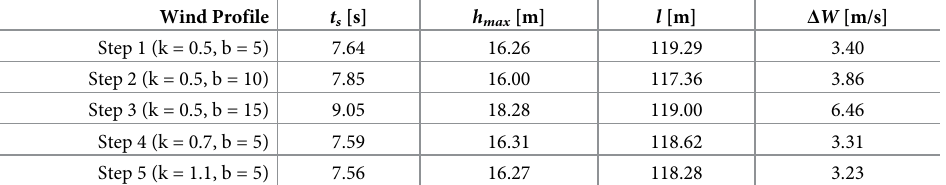
Table 4. Comparison between dynamic soaring trajectories for different wind profiles, for initial airspeed of 20m/ s and initial height of 1.5m.